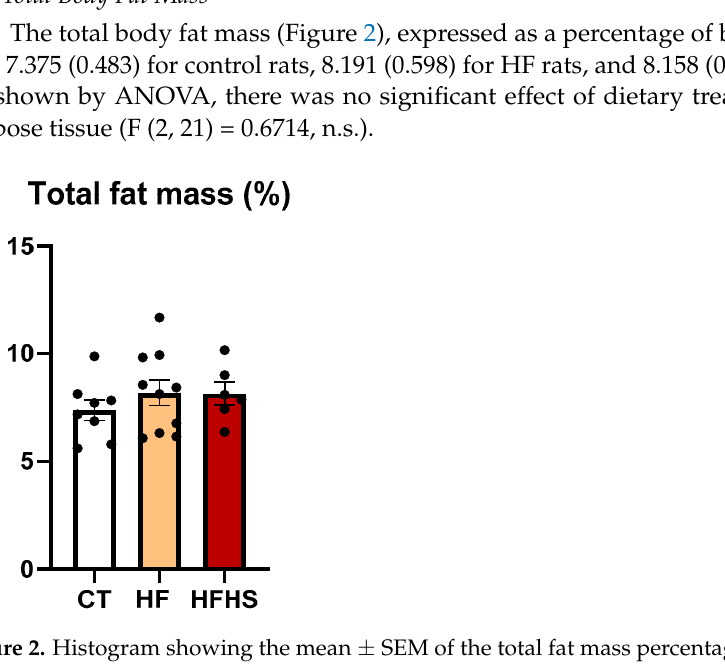
Figure 2. Histogram showing the mean ± SEM of the total fat mass percentage of control, HF, and HFHS animals. No significant differences were observed between groups. Dark circles represent the percentage of total fat mass per body weight of each